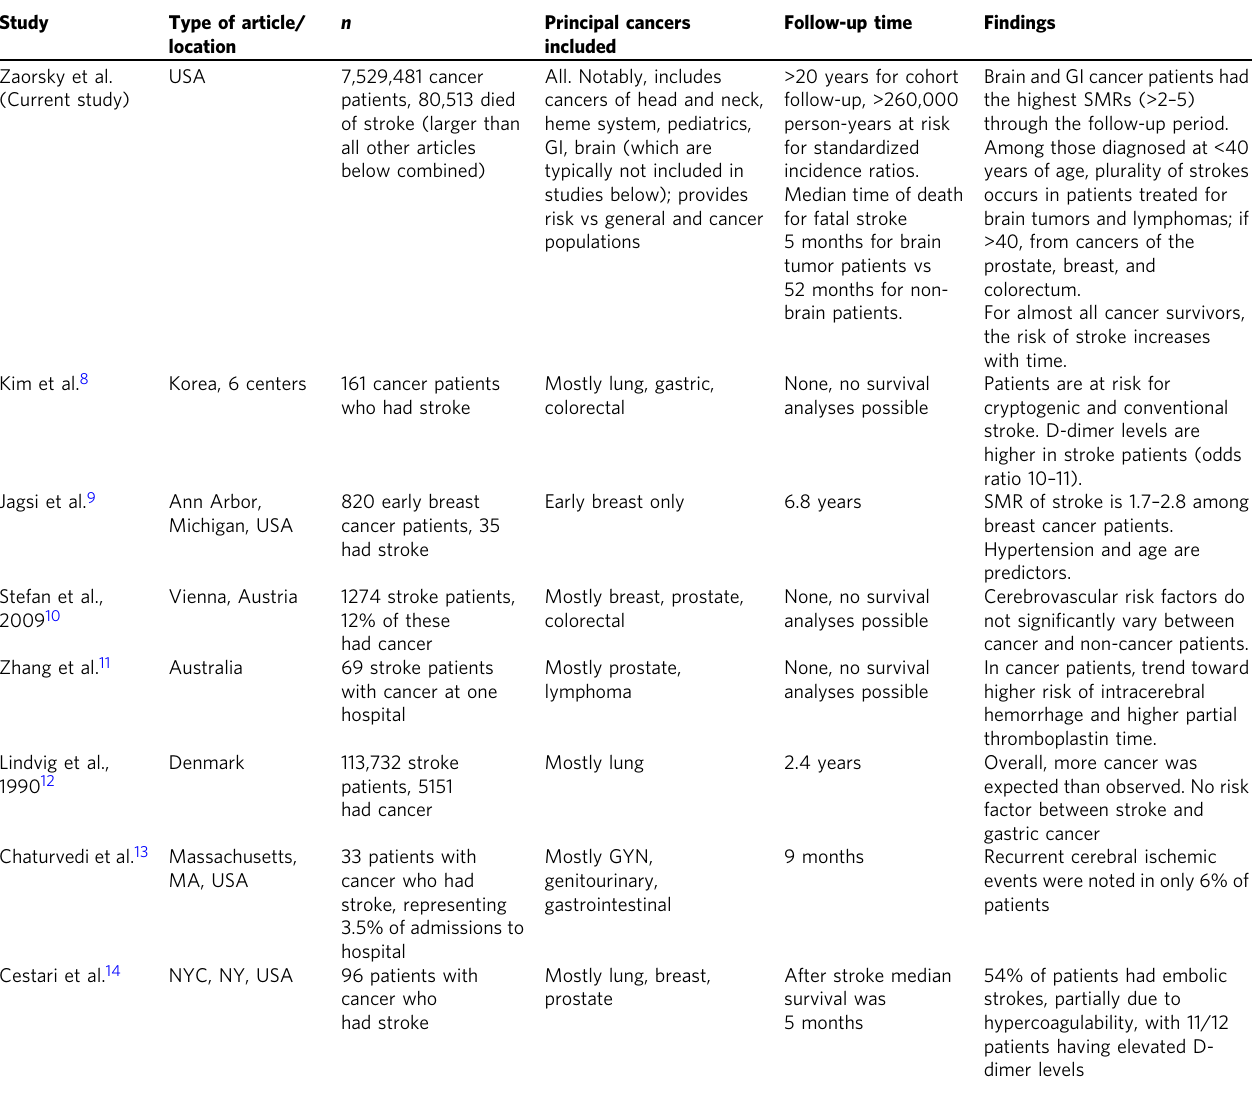
Table 3 Literature review on the analyses of stroke among cancer patients